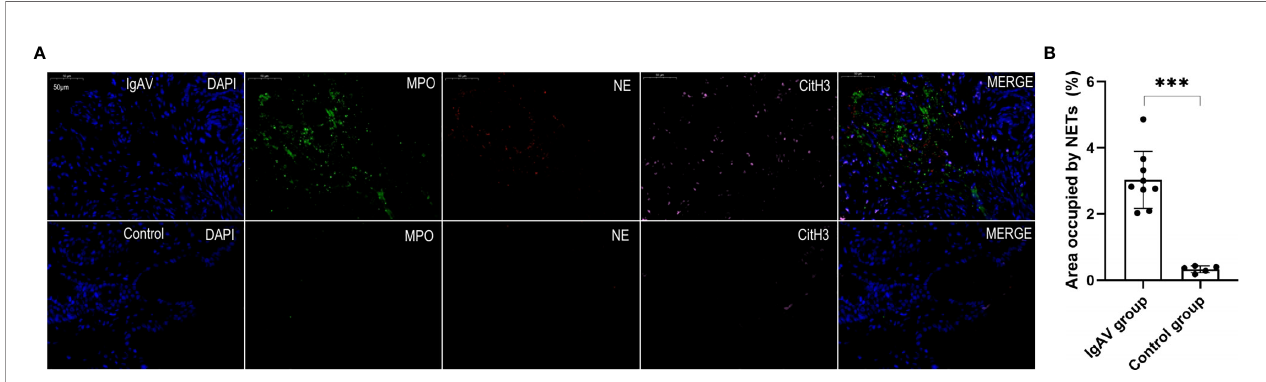
FIGURE 6 | (A) Staining of gastric antrum tissue in order to visualize NETs. NETs were present in the mucosa of gastric antrum of an IgAV patient but absent in a healthy control tissue. The micrographs are from representative a IgAV patient and a healthy control. (B) Area occupied by NETs in gastric tissue, as determined by image analysis. ***P